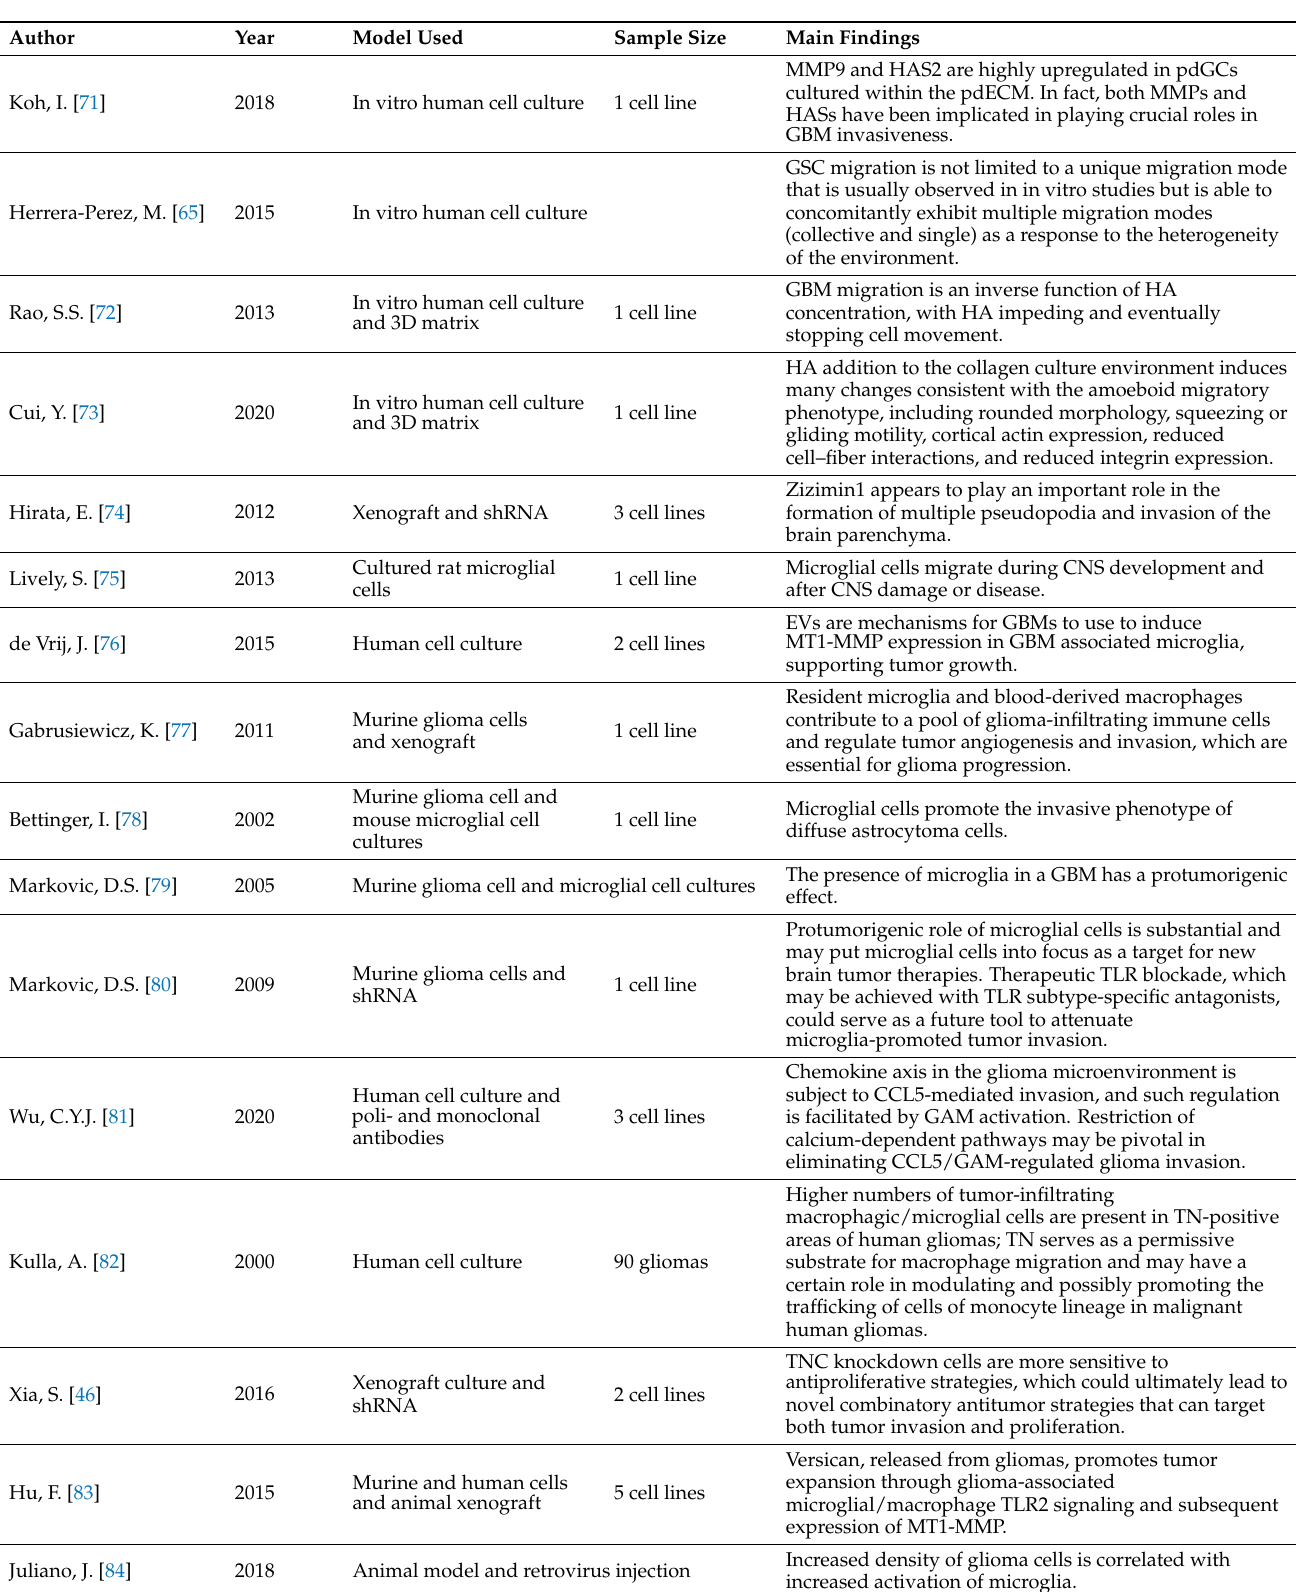
Table 7. Glioma cell and microglia migratory and infiltrative